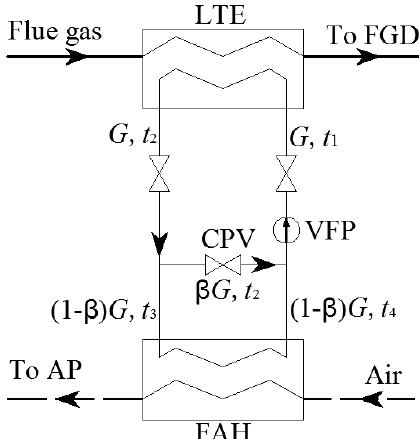
Figure 4. Improved LTE–FAH system. AP: Air Preheater; FAH: Front located Air Heater; LTE: Low Temperature Economizer; FGD: Flue Gas Desulfurization. CPV: Crossover Pipe Valve. VFP: Variable Frequency Pump. G : Flow rate of liquid medium. t 1 , t 2 : Inlet and outlet temperature of liquid medium in LTE, respectively. β : Ratio of crossover pipe flow to VFP flow. t 3 , t 4 : Inlet and outlet temperature of liquid medium in FAH, respectively.